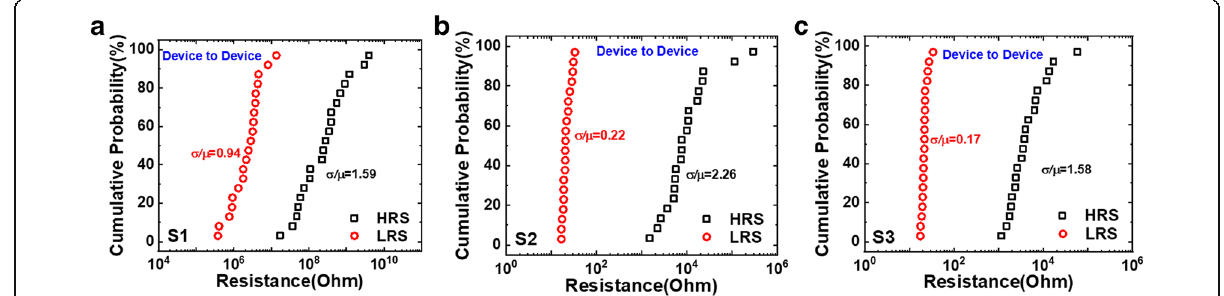
Fig. 7 Device-to-device variation of R LRS and R HRS for 20 devices in a S1, b S2, and c S3